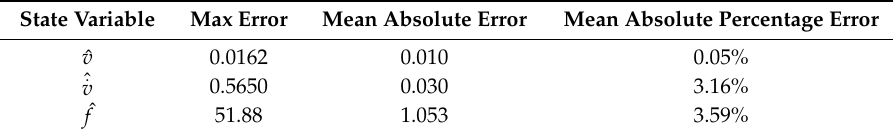
Table 5. Statistical indicators of extended state observer-computed results.